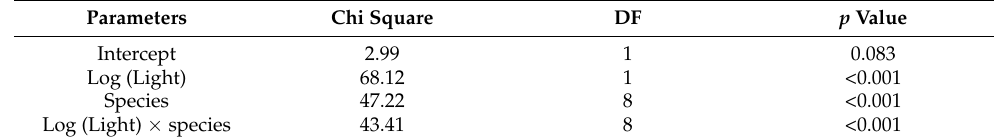
Table 2. Analysis of Deviance table (Type III Wald chisquare tests) of the mixed-effect regression model (Equation (2)) describing the effect of light on growth responses of 9 species.